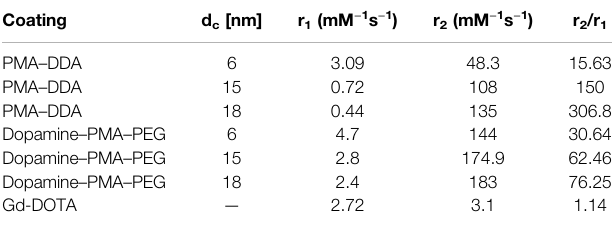
TABLE 2 | Proton relaxivities r 1 and r 2 for IONPs with core sizes of d c (cid:2) 6, 15, and 18 nm and two different polymer coatings, as measured at 3 T in water.